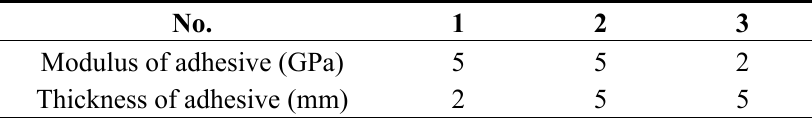
Table 2. Numerical cases for the single-rod